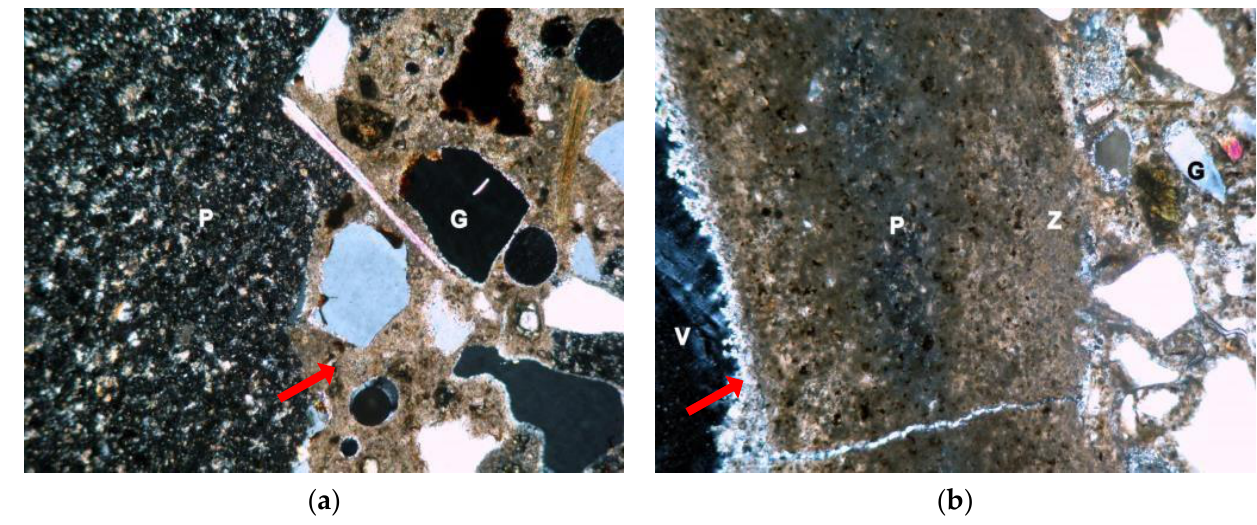
Figure 7. Cross nicol photomicrograph ( a ) and ( b ), transmitted light microscope, 50x magnification.